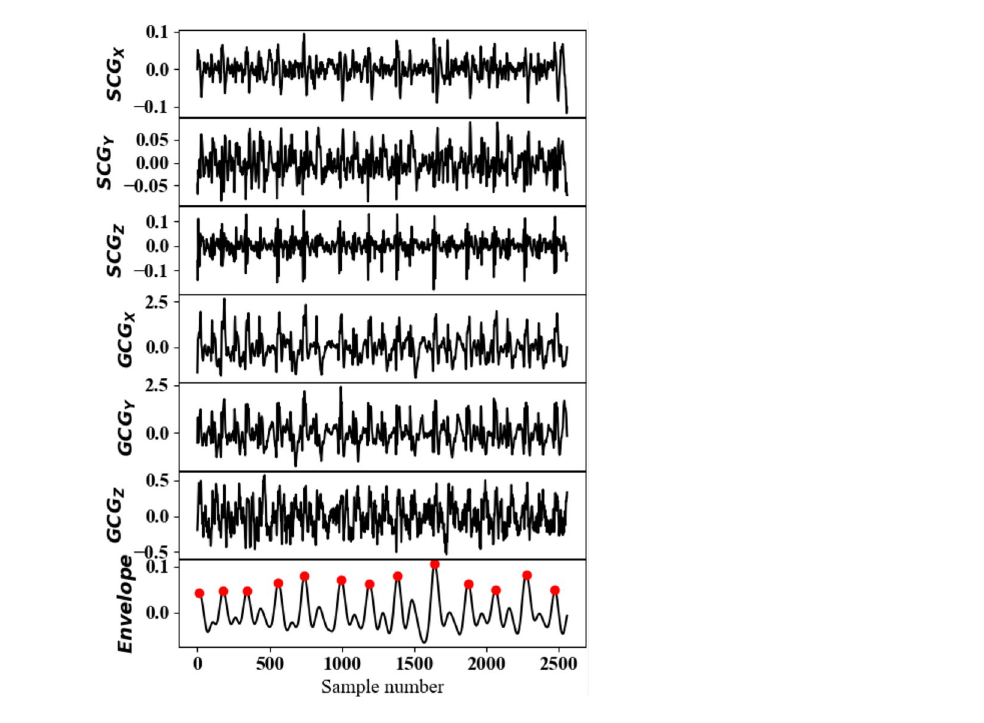
Figure 5. Beat detection from SCG and GCG channels, from top to bottom: SCG X , SCG Y , SCG Z , GCG X , GCG Y , GCG Z , and the envelope